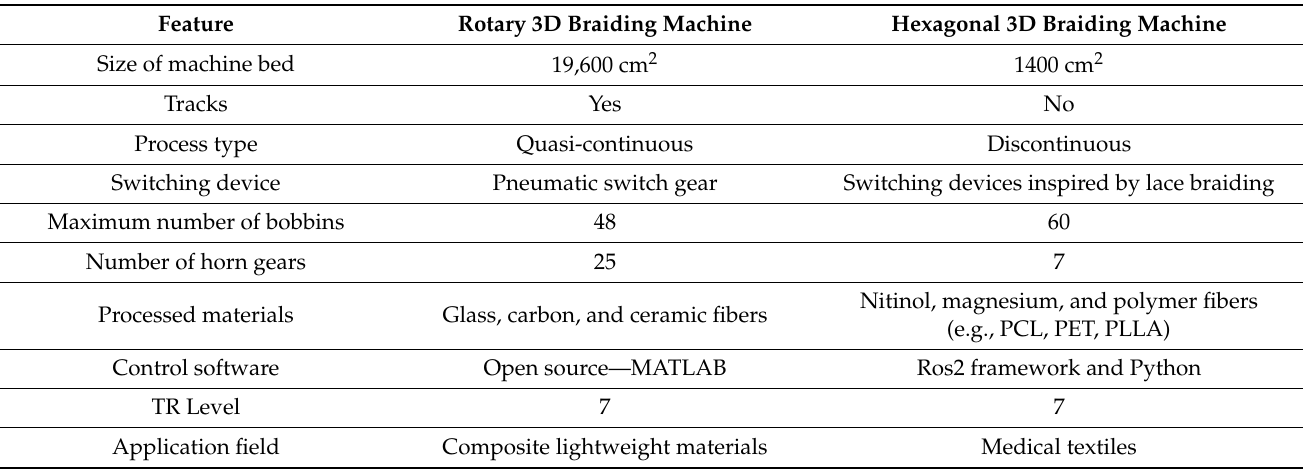
Table 1. Comparison of 3D braiding machines at